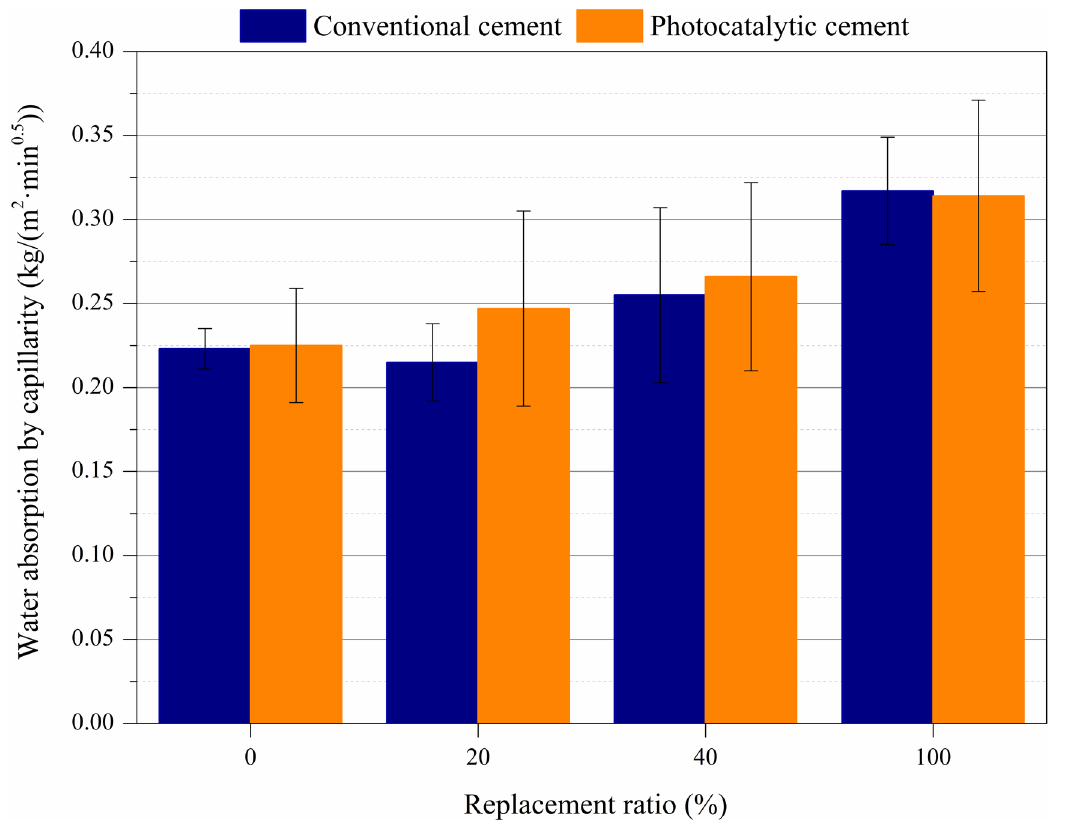
Figure 5. Water absorption by capillarity comparison.